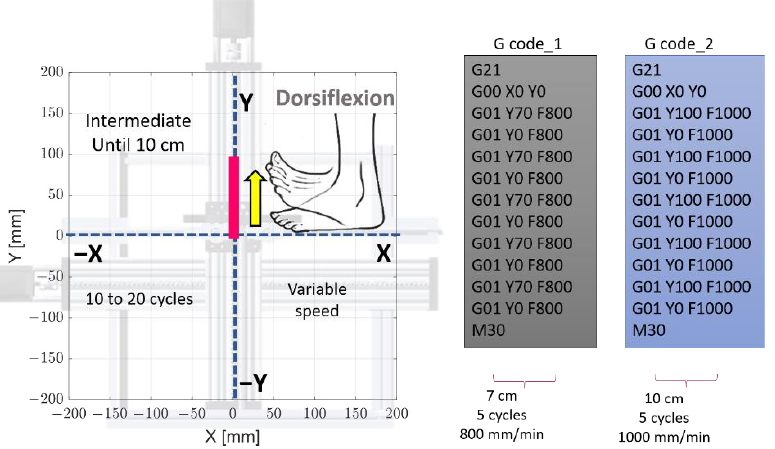
Figure 17. Intermediate level for dorsiflexion rehabilitation.